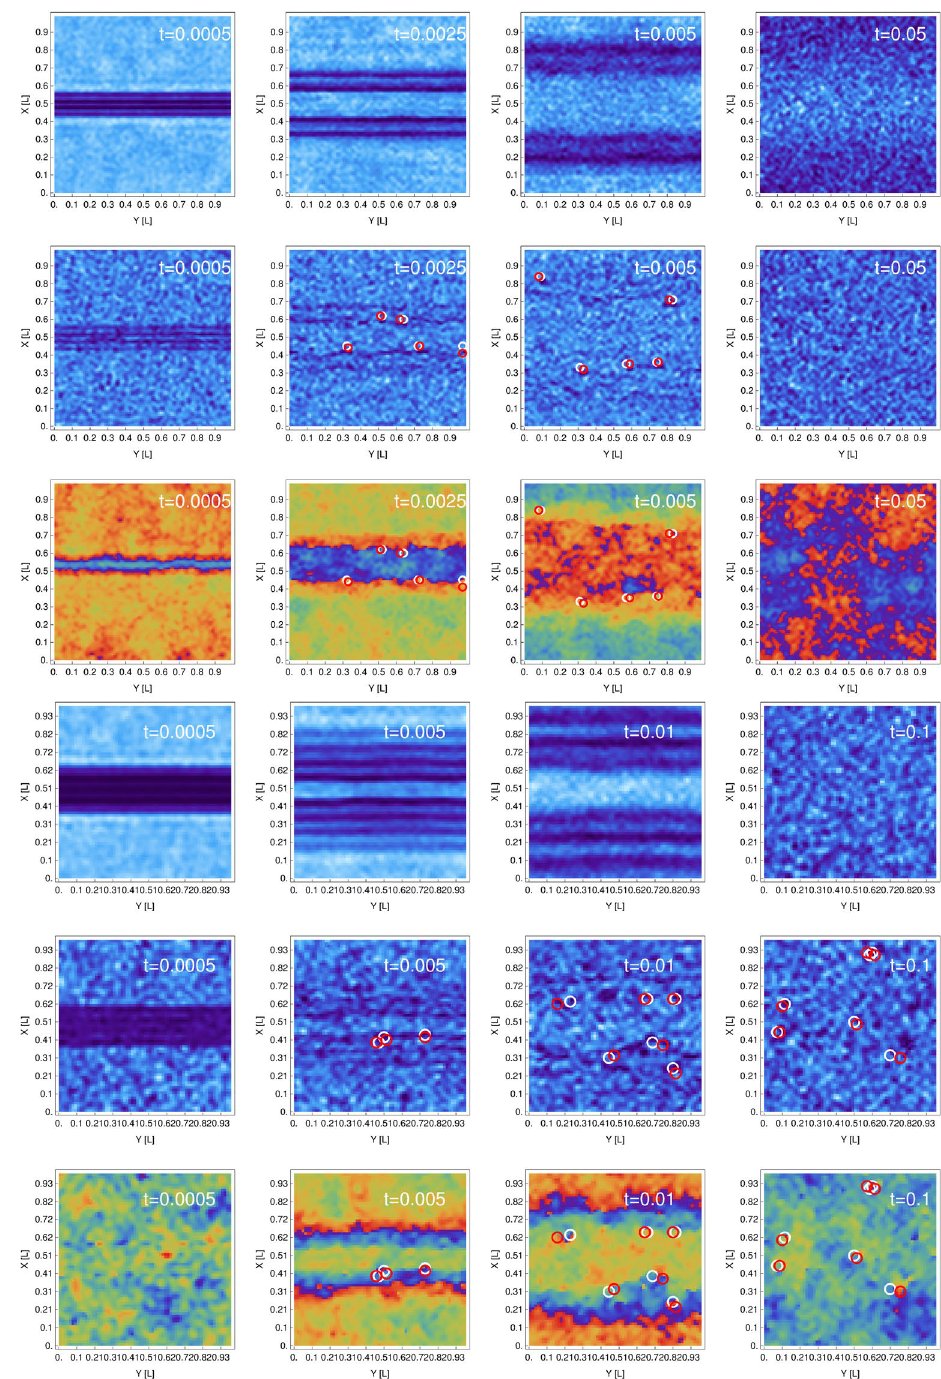
Figure 4. First (from the top) row: 2D time-snapshots of a density (averaged over 100 realizations) for different times as labeled in frames. Second (third) row: 2D densities (phases) for a single realization, with marked white and red circles surrounding elementary vortices with opposite signs. Vortices are identified by calculating the change of the phase around each plaquette of our numerical grid. Here, w / L 0.37 T and T c , which corresponds to the middle lower row frame in Fig. 2. Next three rows show the same = 0.56 T 12 / 34 , d 14 / 16 , and T quantities but for w / L c (see Fig. 5). The spatial resolution is = = = is 1.39 of the healing